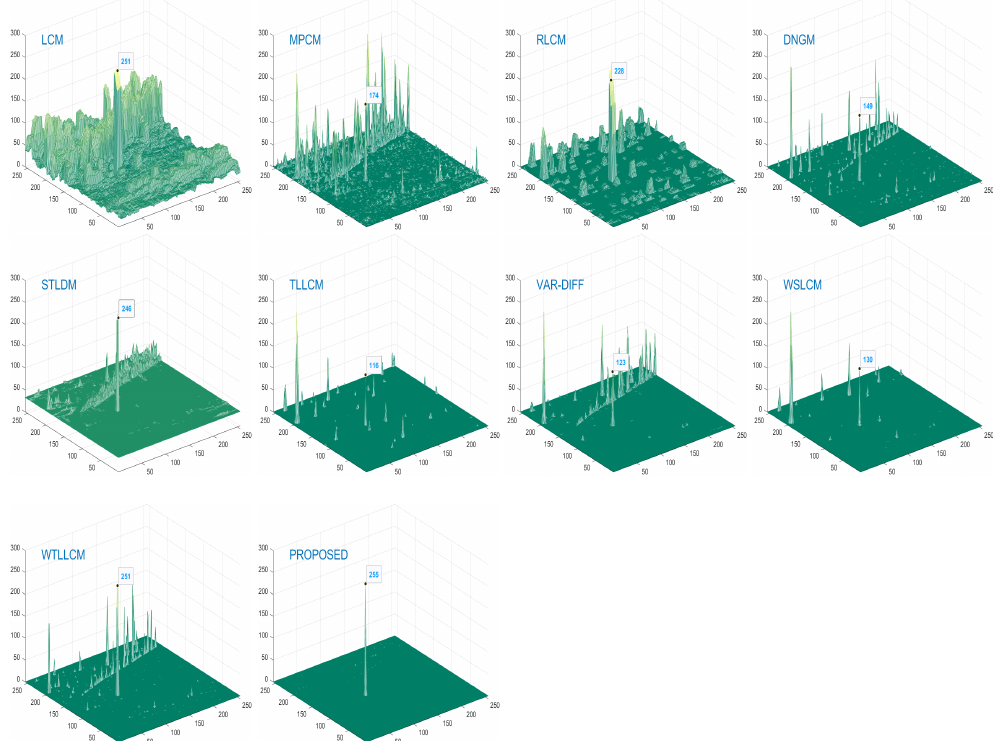
Figure 18. Three-dimensional displays of detection results on one frame in data2. Different subgraphs are the results of different